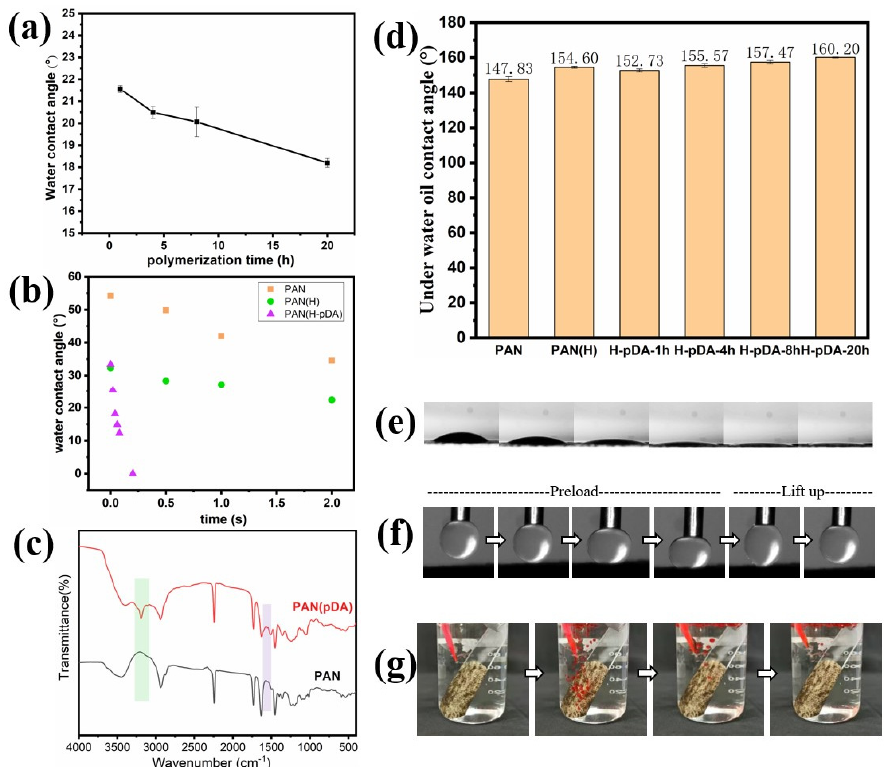
Figure 4. ( a ) Contact angles measured in air of H-PDA prepared at different polymerization times. ( b ) Water contact angles of different membranes versus drop time. ( c ) FT-IR spectrum of PAN and H-PDA. ( d ) Under water oil contact angle of different membranes. ( e ) Digital photos of the changes in the water contact angle changes after the drop of the droplet. The entire process shown by the images occurred within 0.25 s. ( f ) Dynamic underwater–oil adhesion of H-PDA. ( g ) Real-time images